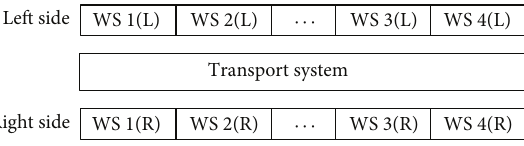
Figure 1: Configuration of two-sided assembly lines